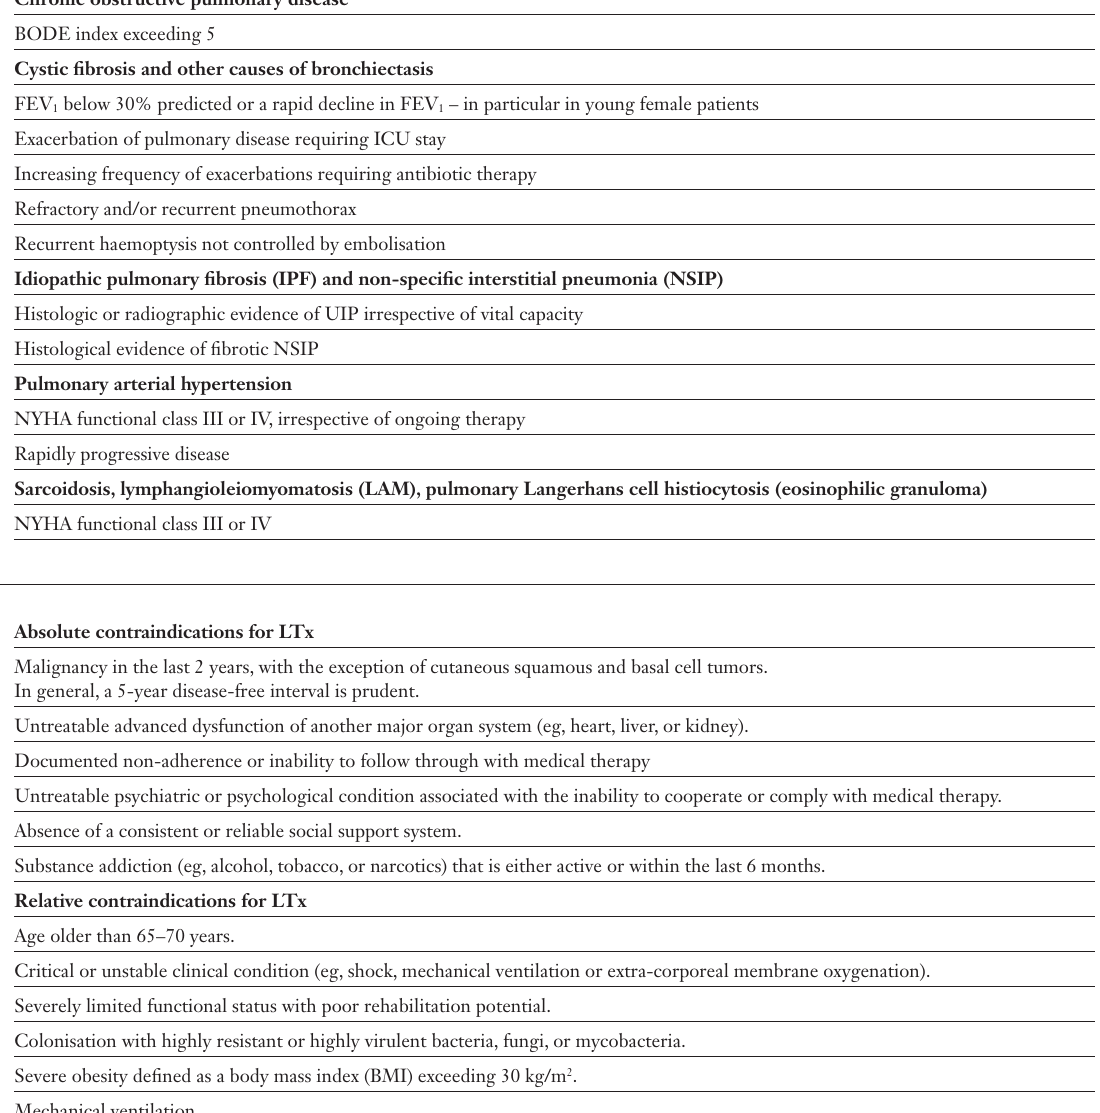
Time for referral to a lTx-centre.